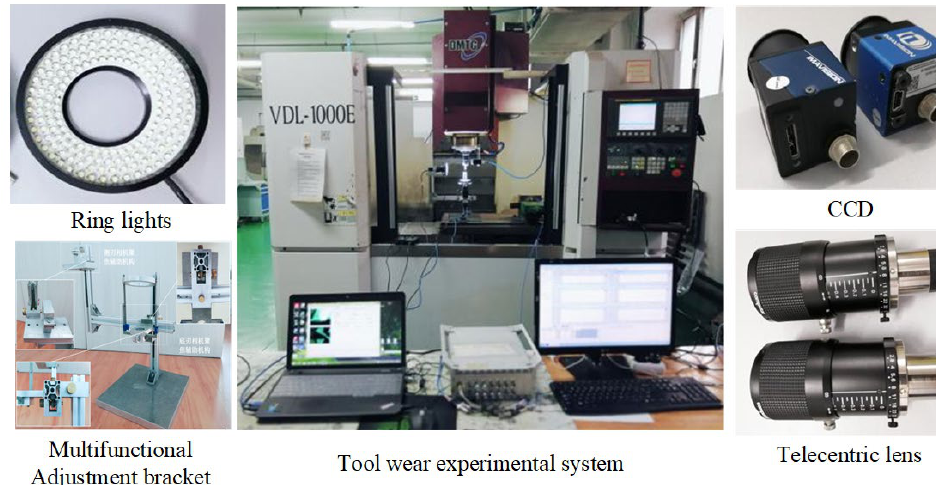
Figure 1. The experimental system.